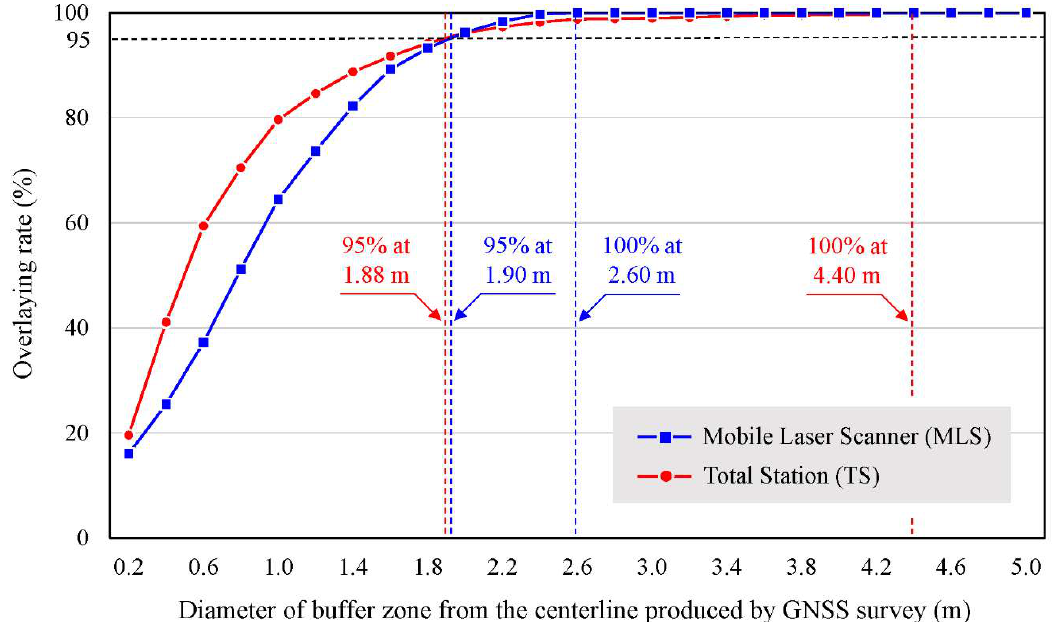
Figure 7. Changes in mean ratios of the comparative maps by Mobile Laser Scanner (MLS) and Total Station (TS) surveys overlaid to the buffer zones of the Global Navigation Satellite System (GNSS) survey reference maps for the four forest road routes.